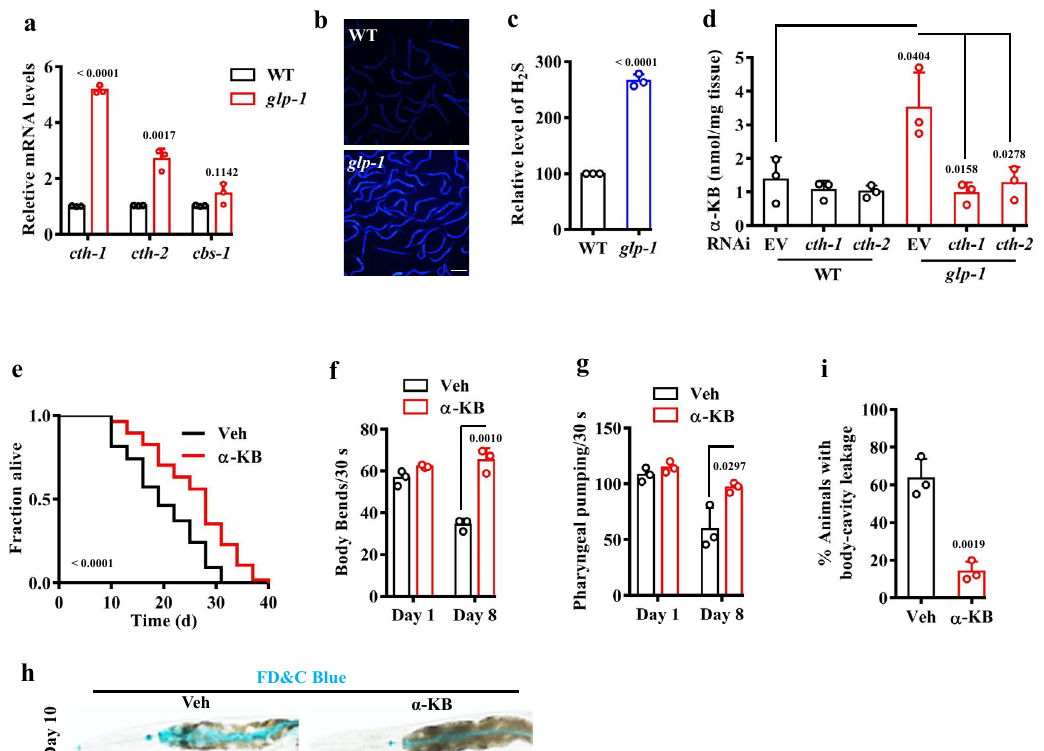
Fig.1|Alpha-KBpromoteslifespaninworms.a ThemRNAlevelsof cth-1 and cth- 2 ,butnot cbs-1 ,wereupregulatedin glp-1 ( e2141ts )mutants,comparedwiththosein wild-type (WT) worms. These results are means±SD of three independent experiments. b , c Representative images of H 2 S formation detected by a fl uor- escent probe. A similar pattern of H2S formation was observed in three indepen- dentexperiments.Scalebars:500 μ m. c Quanti fi cationof fl uorescentintensityin b . The content of H 2 S was increased in glp-1(e2141ts) mutants, compared with that in WT worms. Data were presented as mean values±SEM of three independent experiments ( n =35 worms per experiment). P values ( a , c ) were calculated using the two-sample t -test. d The levels of α -ketobutyrate ( α -KB) were increased in glp- 1(e2141ts) mutants, compared with that in WT worms. RNAi knockdown of either